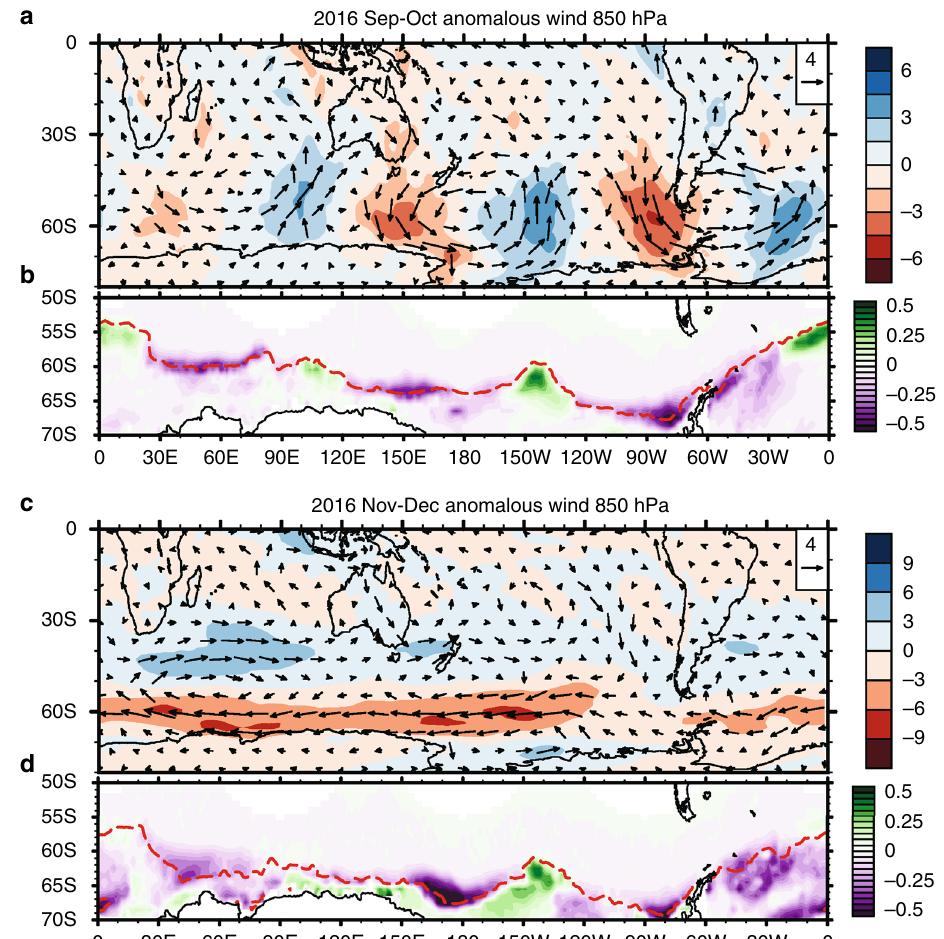
Fig. 2 Atmospheric circulation and sea-ice concentration during September to December 2016. a Sep – Oct 850 hPa wind anomaly (vectors, scale in upper right, m s − 1 ); Shading is meridional wind component with northerly coloured in reds and southerly coloured in blues (interval 1.5 m s − 1 ); b Sep – Oct Antarctic sea-ice concentration (SIC) anomaly (shading; interval 0.05); the 0.15 contour is highlighted with red dashed curve. For clarity, SIC anomaly is only displayed in the latitudes poleward of 50 ° S. c , d are the same as a , b , respectively, but for Nov – Dec 2016. The shading in c is zonal wind component with easterly coloured in reds and westerly coloured in blues (interval 3 m s − 1 ). Plots were generated using the NCAR Command Language version 6.4.0